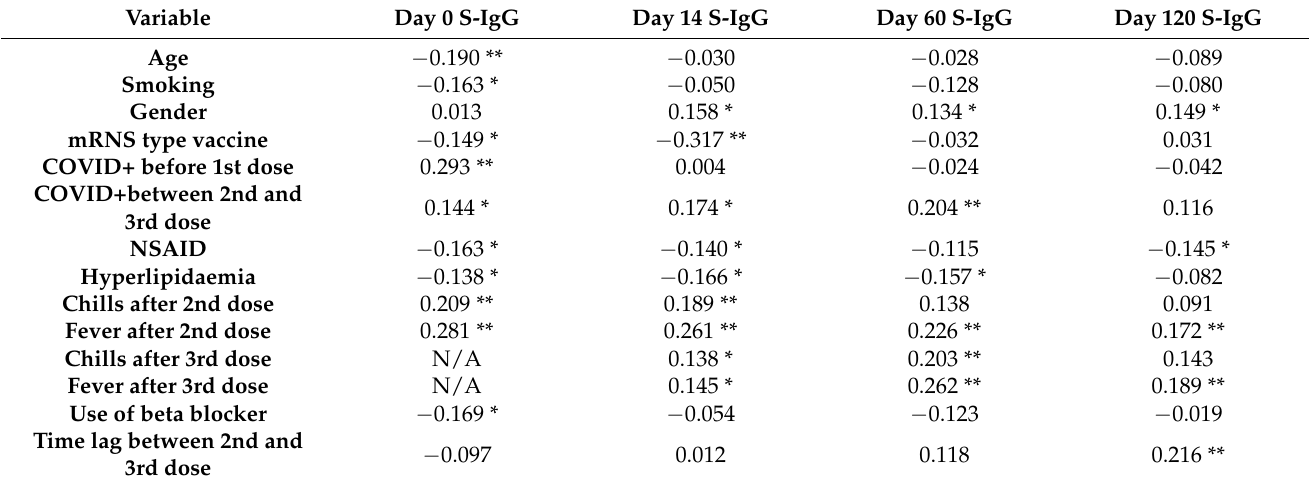
Table 3. Variables associated with levels of S-IgG (AU/mL) in cross-sectional analysis. Day 0, S-IgG measurements immediately before 3rd dose; Day 14, Day 60, and Day 120 S-IgG, S-IgG measurements on 14, 60 and 120 days after 3rd dose. Values are Spearman correlation coefficients. * p < 0.05, ** p < 0.001. S-IgG, anti-spike immunglobulin; AU, arbitrary unit; COVID+, confirmed corona virus disease-19, mRNS, messenger ribonucleic